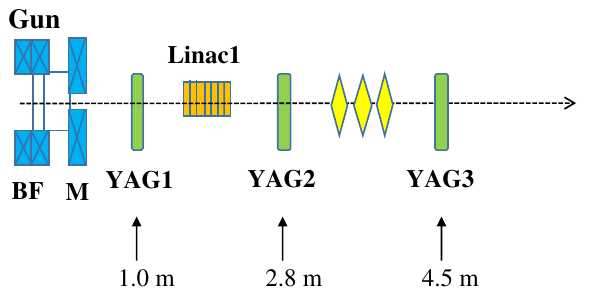
FIG. 11. Overview of the AWA-WB beam line. The bucking (B) and focusing (F) solenoidal lenses can be set up to produce CAM-dominated beams. The positions of the YAG viewers are denoted in